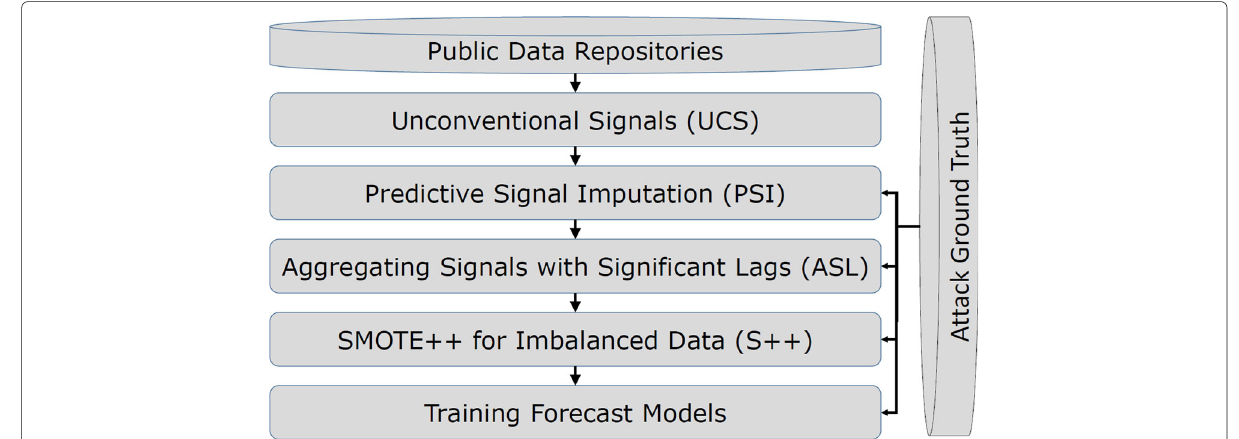
Fig. 1 An overview of the integrated cyber incident forecasting